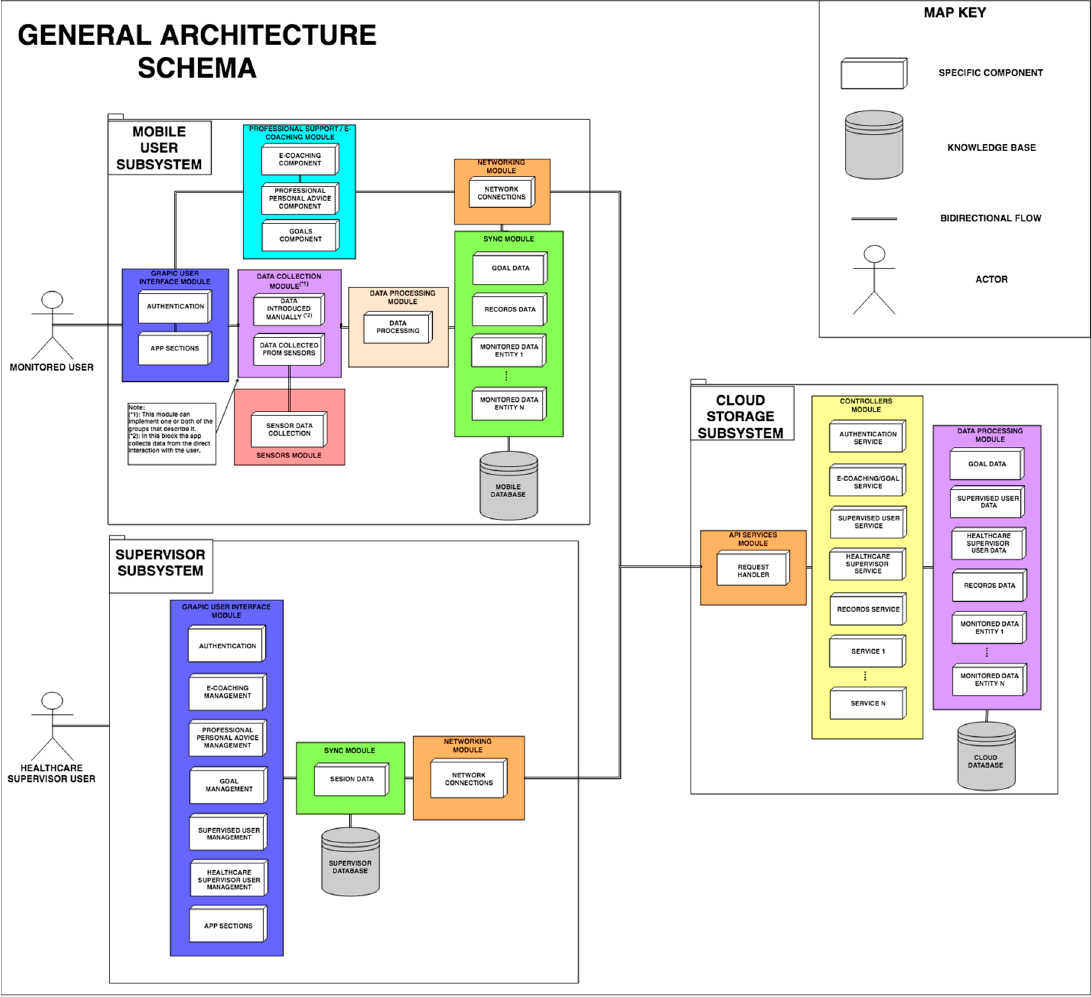
Figure 3. Architecture scheme of the system.